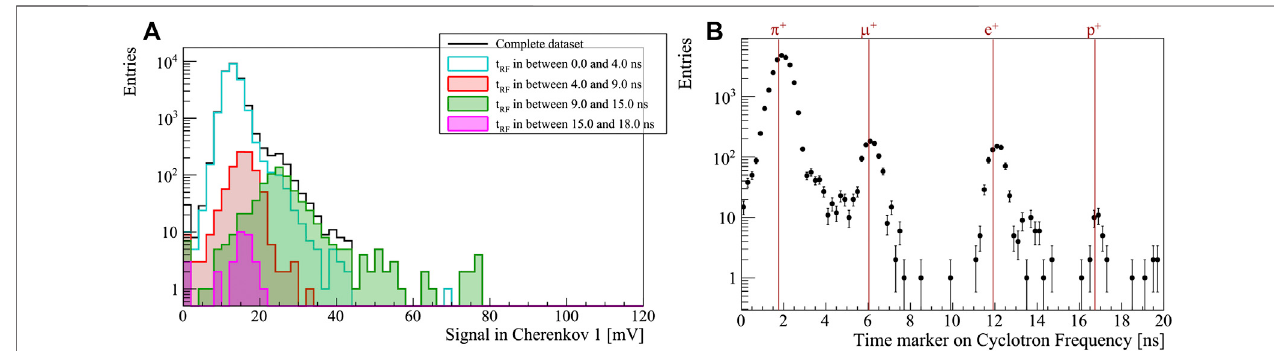
FIGURE12|(A) Thedistribution ofthesignalfromtheupstreamCherenkovdetectors infourintervalsoftherelativeradiofrequencytime t RF . (B) Thedistributionof t RF in a dataset of 1.5 × 10 5 waveforms. The four peaks are associated to, from left to right, pions, muons, positrons, and electrons produced in proton interactions downstream thelast magnet.The red vertical lines represent theexpectations for thefour masshypothesescomputed relative to thepositrons,whose peak isidenti fi ed by means of the Cherenkov photon